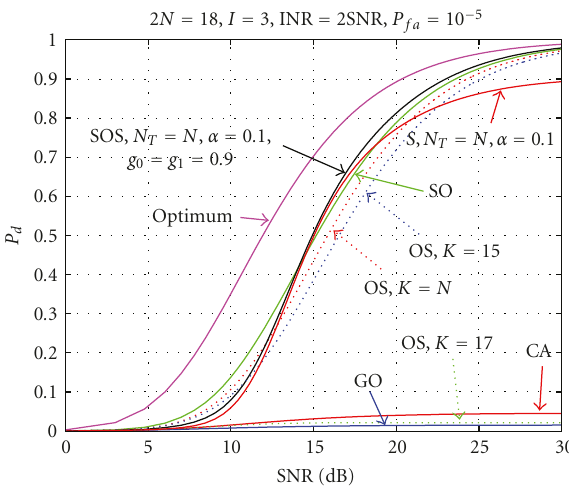
Figure 9: Comparison of P fa for CA, GO, SO, OS ( k = N = 9), and SOS I processors (2 N = 18 and CNR = 10dB).